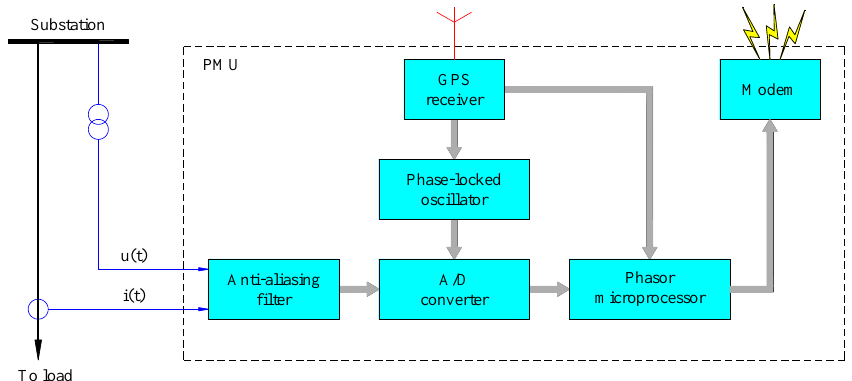
Figure 3. Schematic diagram of a phasor measurement unit (PMU) connected to the power